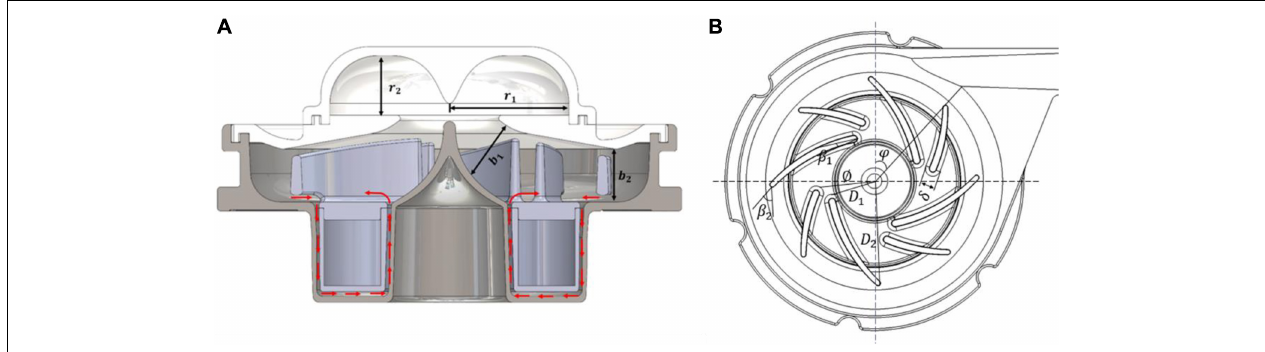
FIGURE 2 | (A) Schematic of the portable blood pump. Red arrows indicate flow direction of the secondary flow path; (B) schematic of the impeller and volute, showing main design parameters.